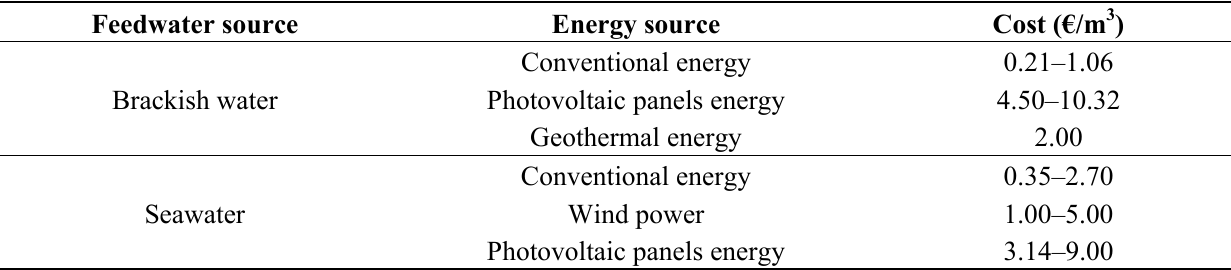
Table 6. Cost of desalinated water production per feeding water and energy source used. Adapted from